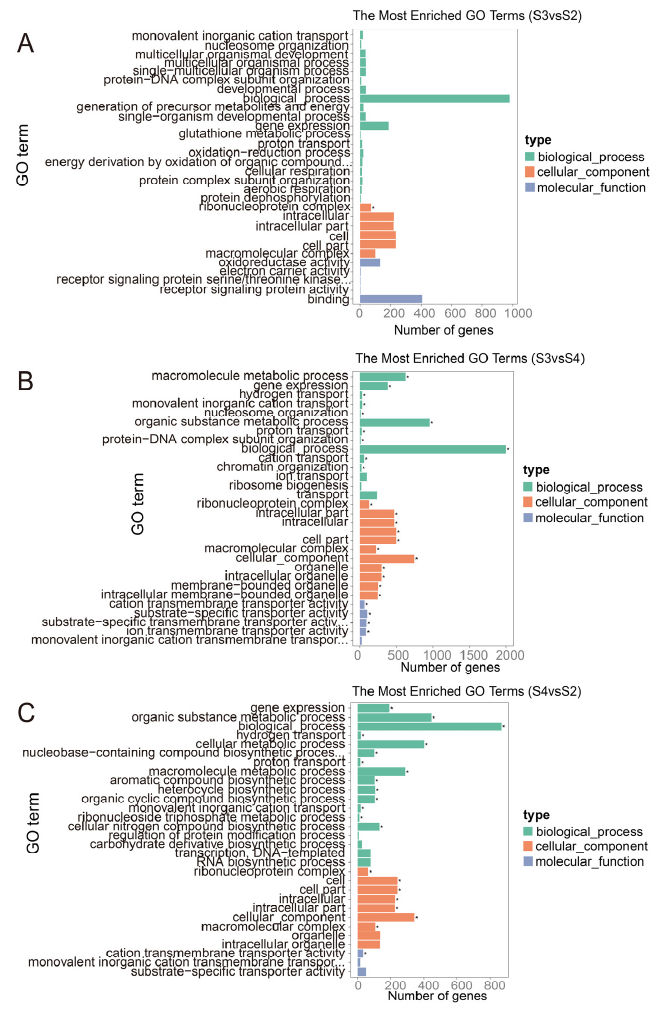
Figure 6. Go enrichment analysis of differentially expressed genes in A. phaeospermum in three periods S2–S4. ( A ): Go enrichment analysis of differentially expressed genes in A. phaeospermum of S3 vs. S2. ( B ): Go enrichment analysis of differentially expressed genes in A. phaeospermum of S3 vs. S4. ( C ): Go enrichment analysis of differentially expressed genes in A. phaeospermum of S4 vs. S2. Note: The green histogram represents biological processes; the orange histogram represents cellular components; the purple histogram represents molecular functions. "*" indicates enriched GOterm. The results of the KEGG enrichment analysis show that the differentially expressed genes in B. pervariabilis × D. grandis were significantly enriched in sucrose metabolism, phenoid biosynthesis, cutin, suberine, wax biosynthesis, plant hormone signal transduc- tion, and plant–pathogen interaction. Compared with S1, 16, 18, and 210 differentially expressed genes of B. pervariabilis × D. grandis in the S2, S3, and S4 stages were enriched in the plant hormone signal transduction pathway, respectively. In addition, 20, 10, and 233 differentially expressed genes were enriched in the metabolic pathway of phe- nylpropanoid biosynthesis. In addition, 10, 7, and 136 differentially expressed genes were enriched in plant–pathogen interactions. The differential gene KEGG enrichment pathways of six comparison groups (S4 vs. S2, S4 vs. S1, S4 vs. S3, S3 vs. S2, S3 vs. S1,